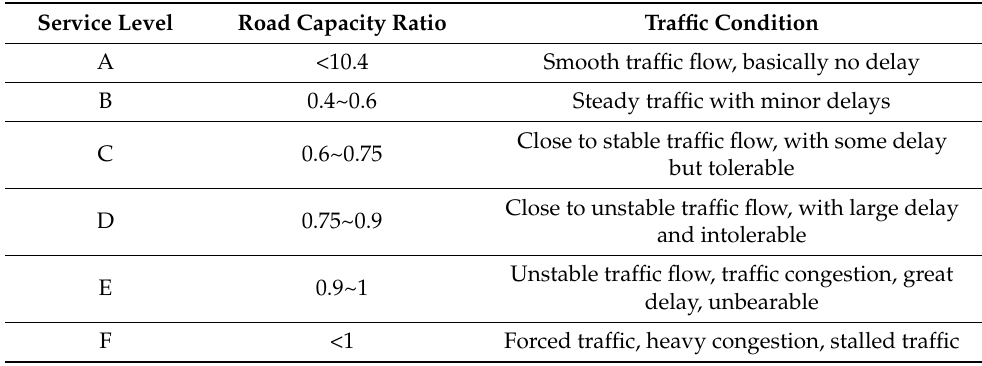
Table 8. Classification of traffic service level in the United States.